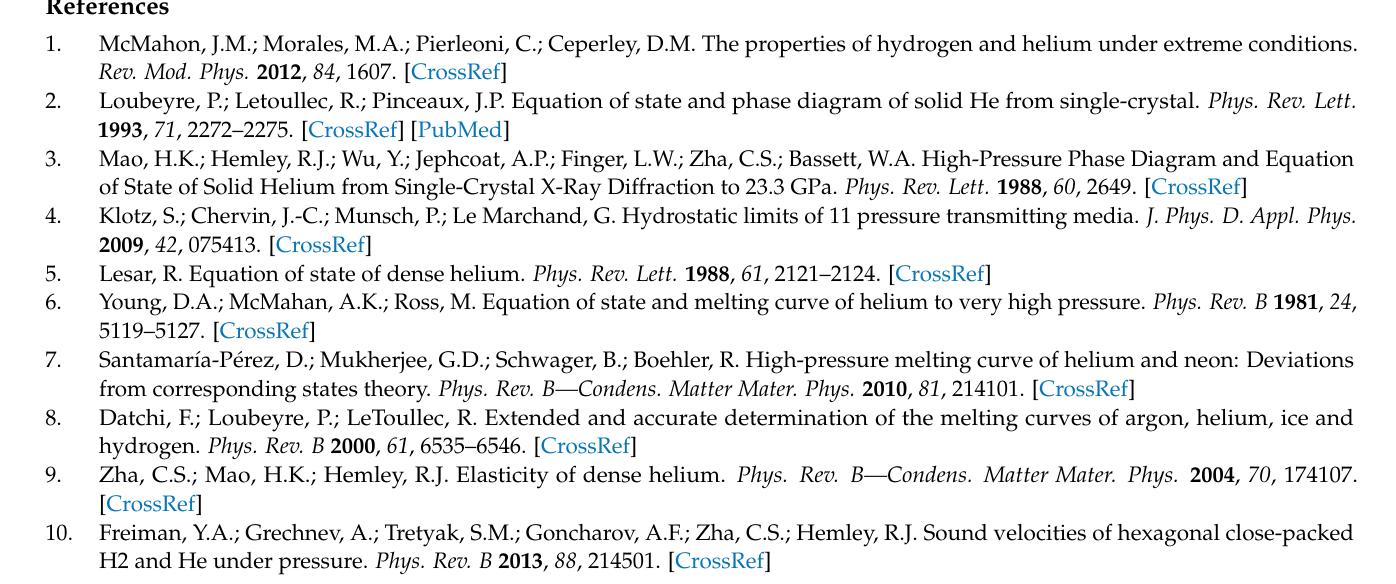
Figure S3: Representative time-domain stimulated Brillouin scattering spectra [19,33] for the liquid He at 7 GPa and solid He at 15 GPa and room temperature. The Brillouin frequency f at 7 GPa and 15 GPa was determined to be 17.1 GHz and 25.6 GHz, respectively, which were used to confirm the phase of the He [12]. Table S1: Input parameters for the bi-directional thermal model calculation at 36.1